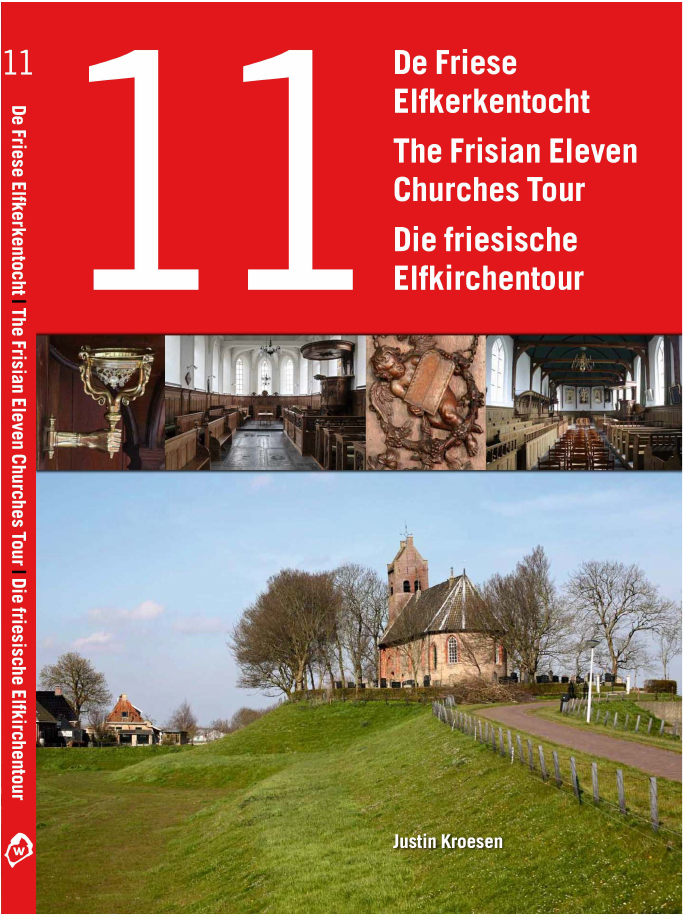
Figure 1. Justin Kroesen, The Frisian Eleven Churches Tour , 2018, book